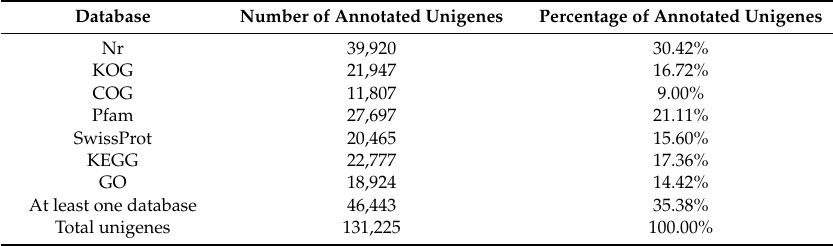
Table 1. Summary of annotation of A. ommaturus